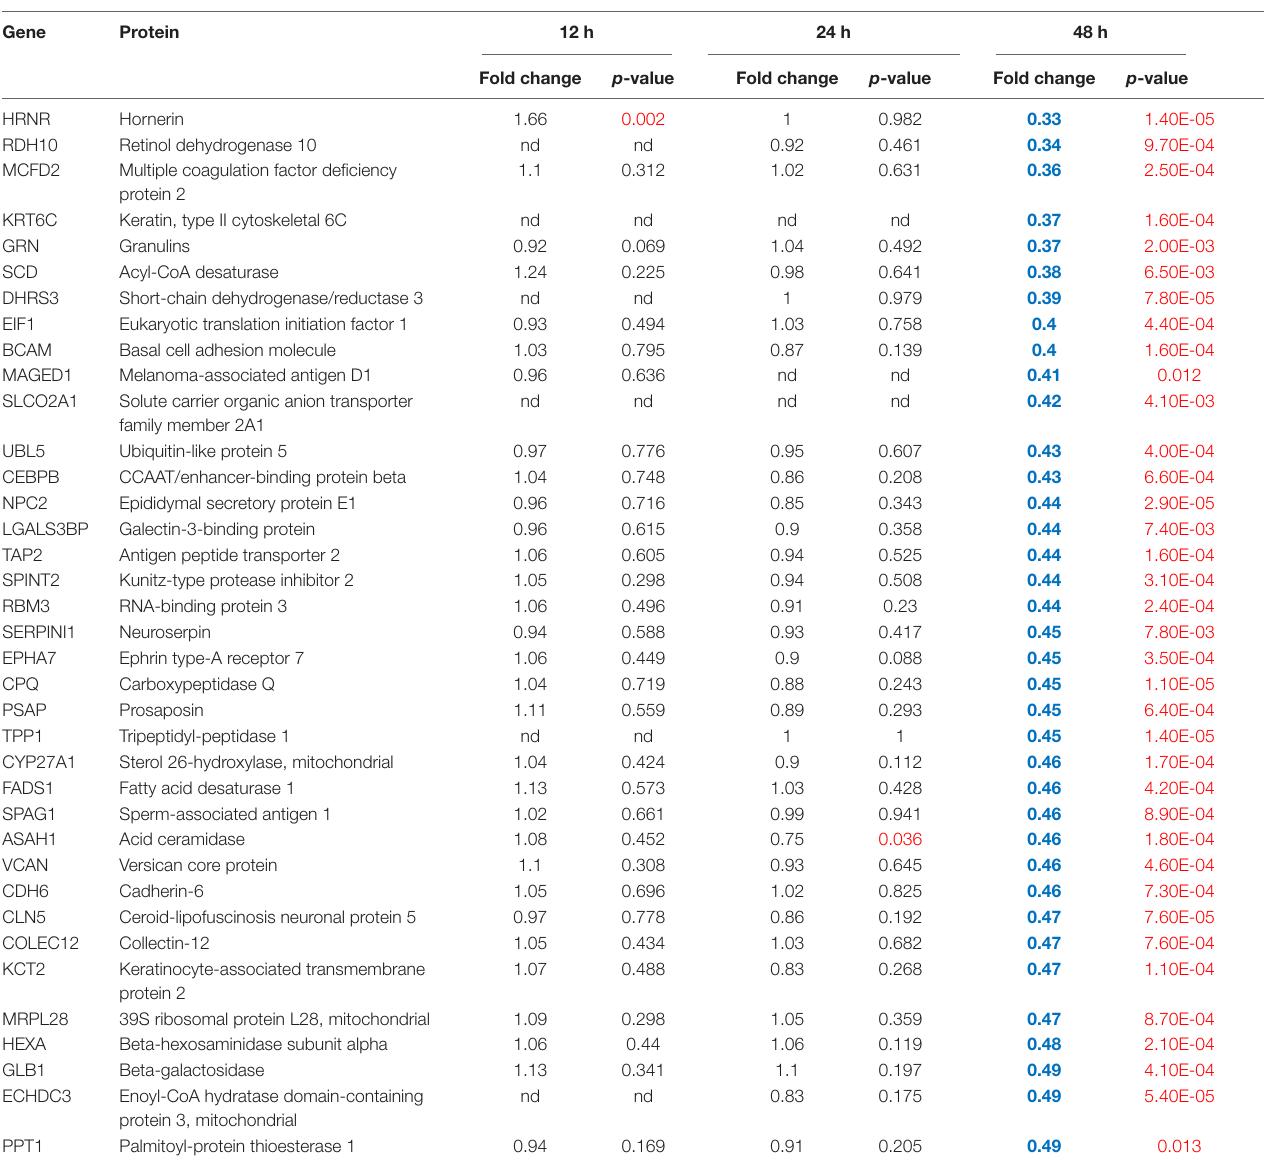
Only proteins dysregulated ≥ 2.0-fold are listed. All proteins are listed in Supplementary Table S1 . Entries are sorted, first by time, from 12 to 48 hpi, then by degree of dysregulation within each set. Values determined from three biological replicates. Proteins with significant p-value are red in T-Test column, those significantly up-regulated are shown in bold red and those significantly down-regulated are shown in bold blue. n.d. = not